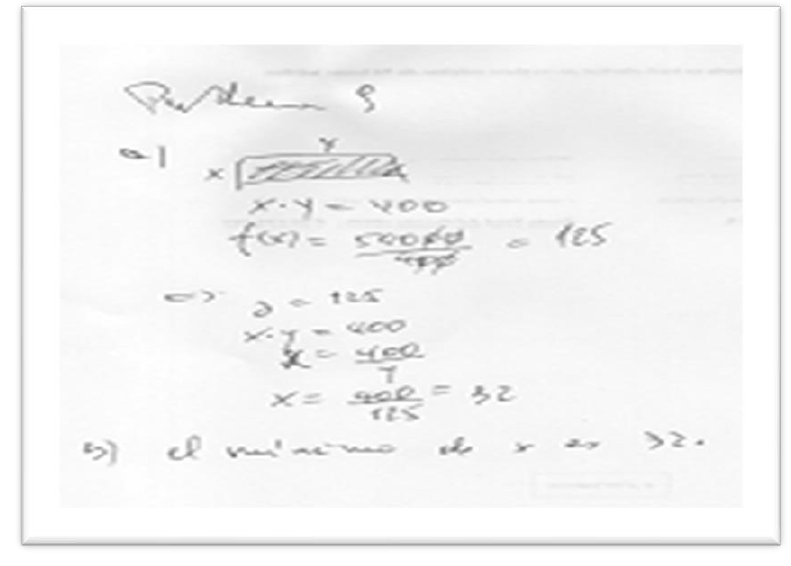
Fig. 5. Production of one